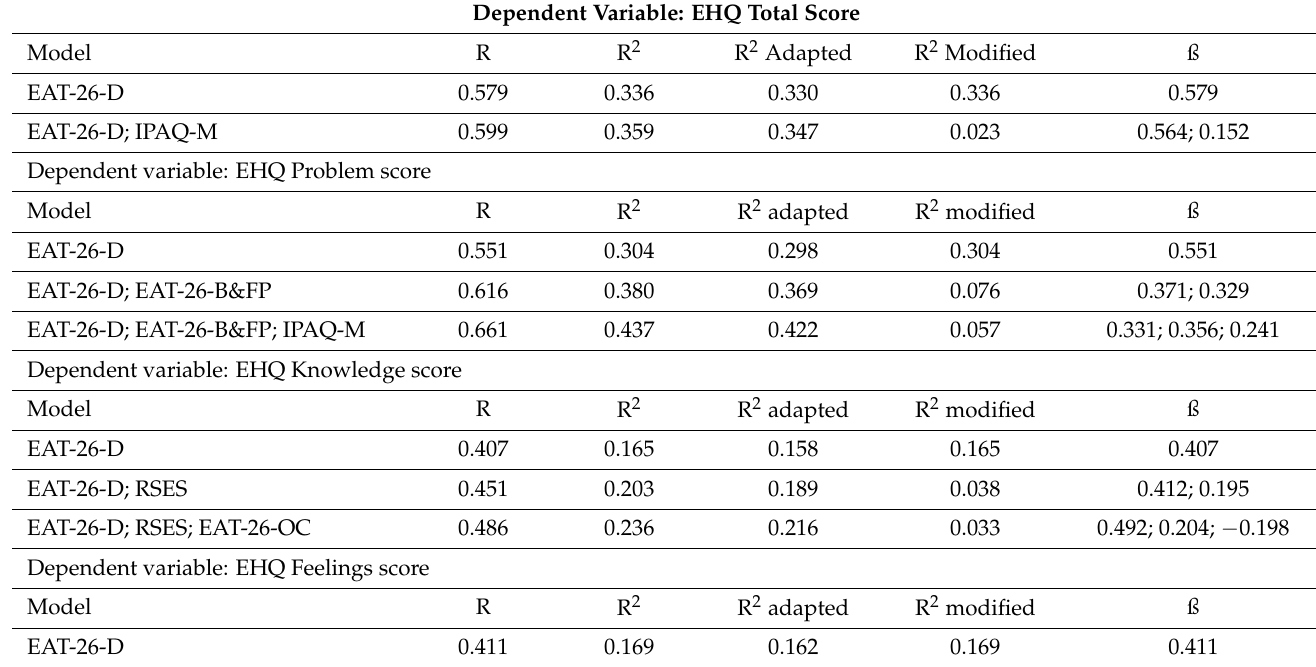
Table 3. Linear Regression with, respectively, the EHQ total, Problems, Knowledge, and Feelings scores as dependent variables.